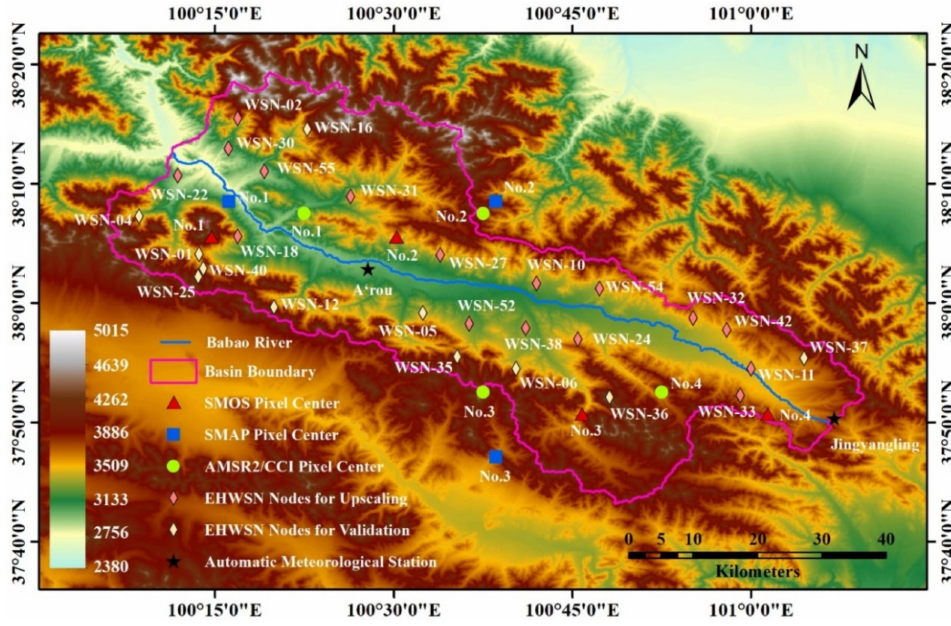
Figure 1. Map of study